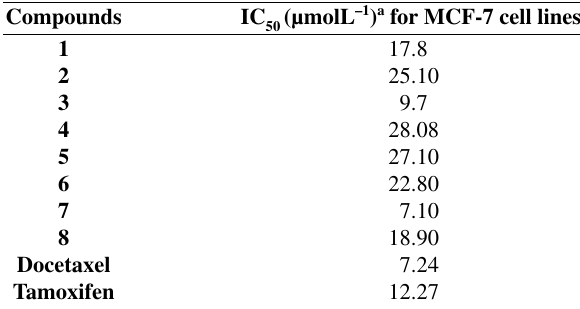
Table 3. Cytotoxicity of compounds ( 1–8) , Docetaxel and Tamoxi- fen against MCF-7 cell